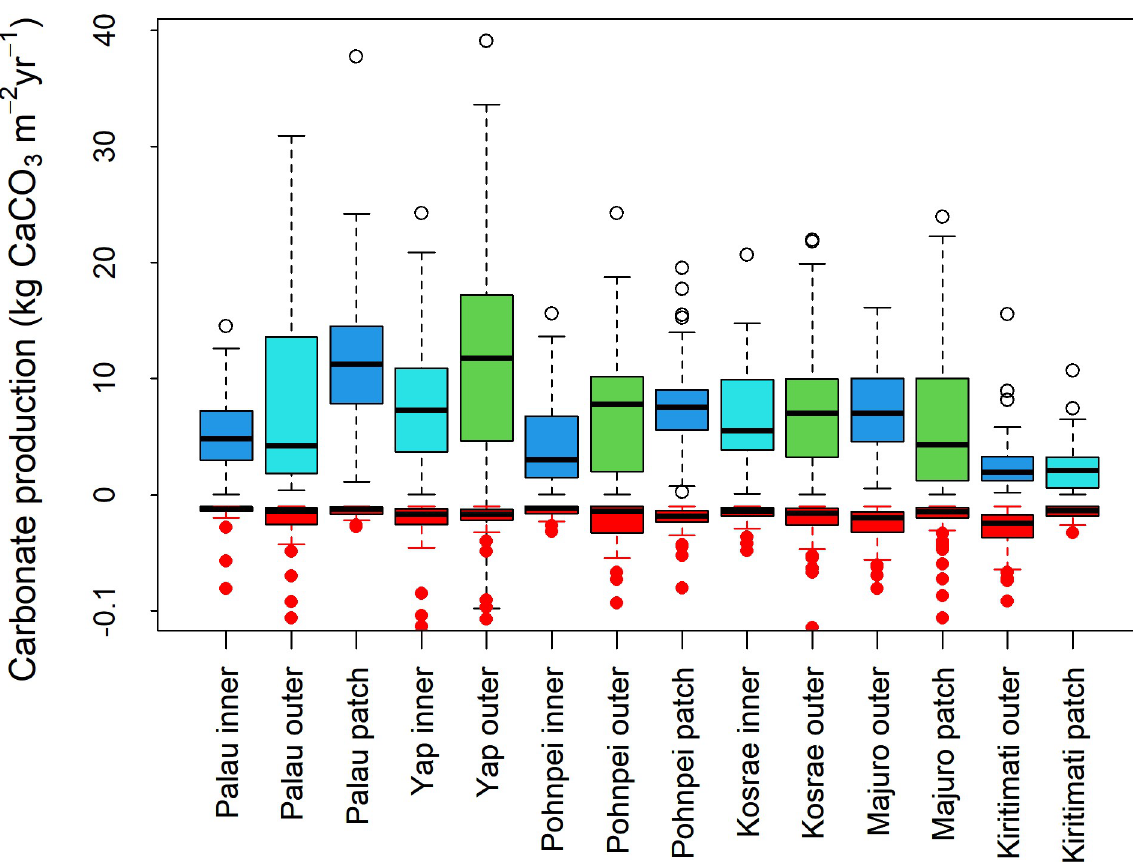
Fig 3. A summary of carbonate production rates (kg CaCO 3 m -2 yr -1 ) in the tropical Pacific Ocean for Palau and Yap (2017), Pohnpei and Kosrae (2018), and Majuro, and Kiritimati (2019), where green represents nearshore reefs, light blue represents patch reefs in lagoons, and dark blue represents outer reefs. The thick horizontal lines are the medians, the boxes surrounding the medians are the first and third quartiles, the whiskers identify the range of the data, and the circles identify the outliers. The red boxes, lines, and circles display the erosion rates.